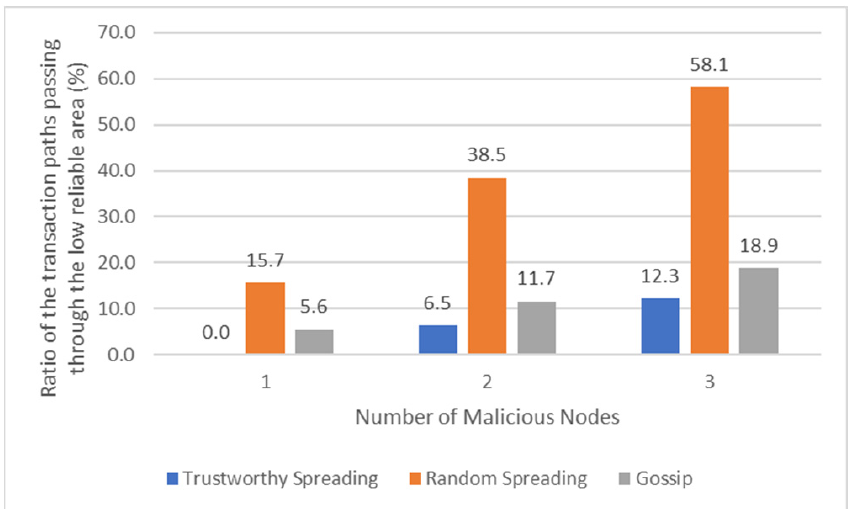
Figure 10. Ratio of the transaction paths passing through the less reliable area.